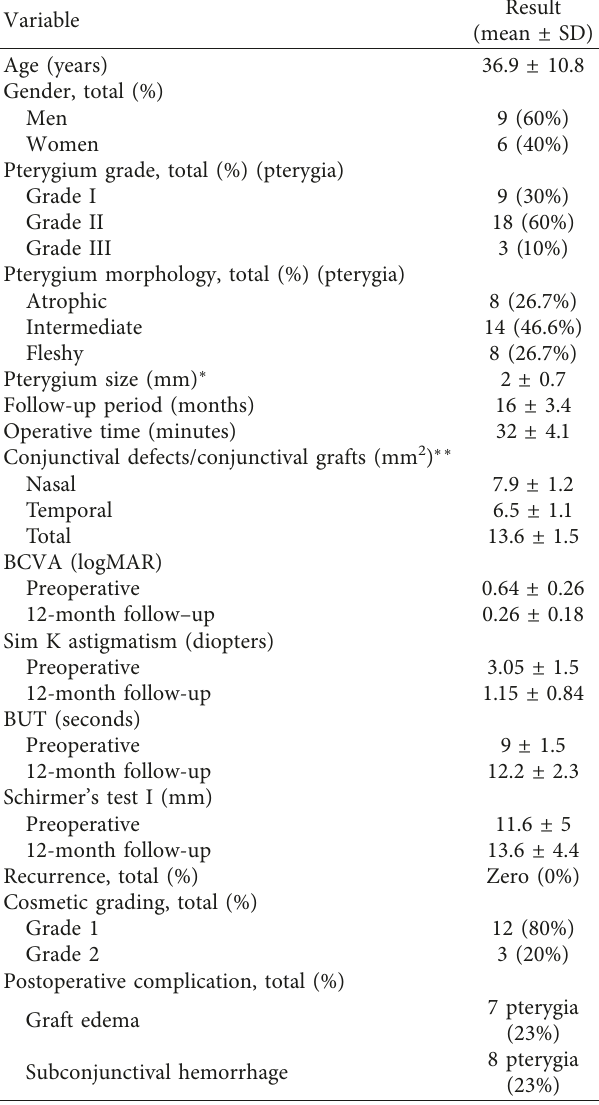
Table 1: Summary of demographic and clinical results.